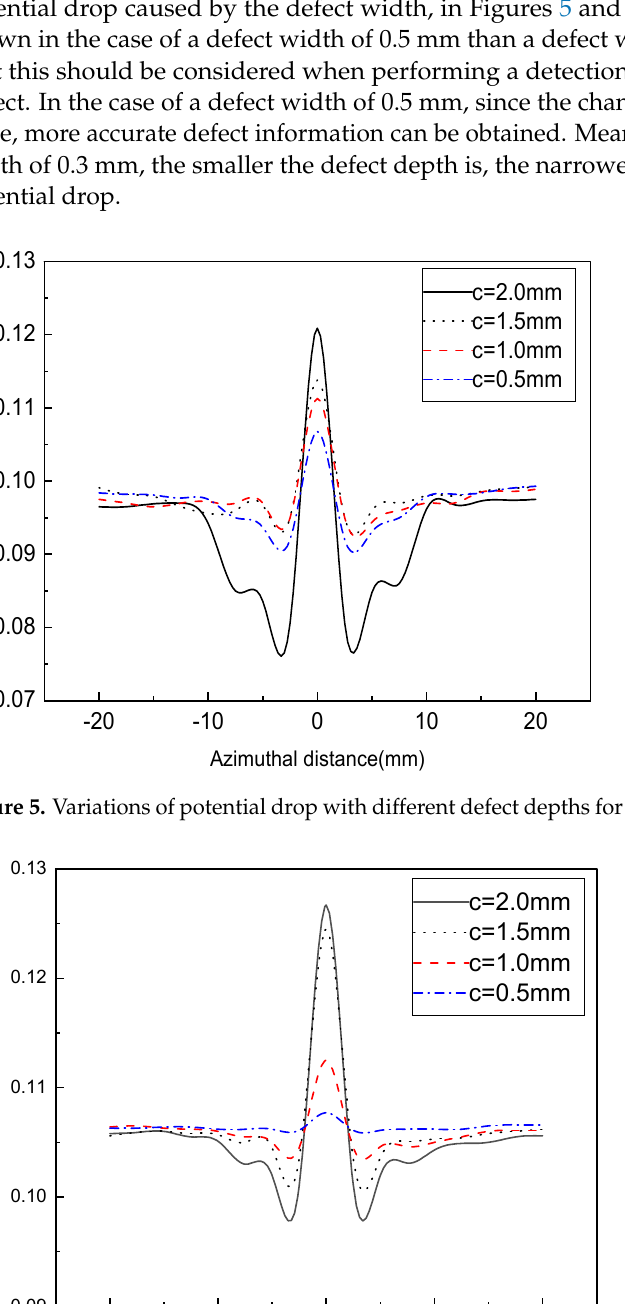
Figure 6. Variations of potential drop with different defect depths for a surface crack width of 0.3 mm.